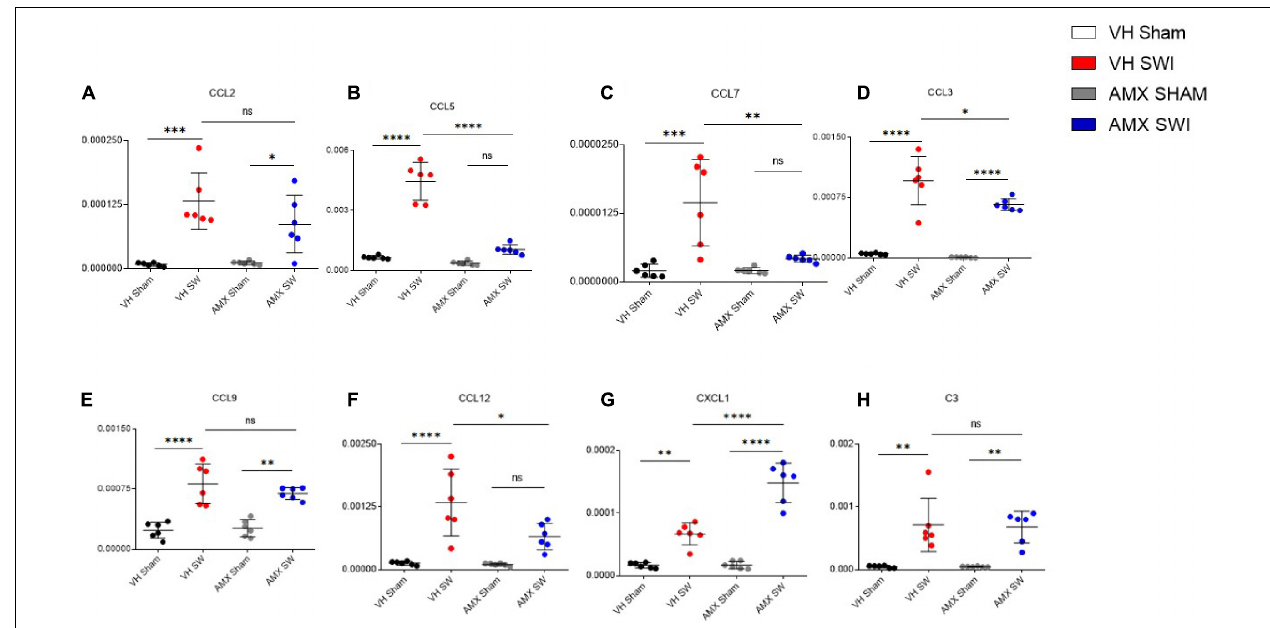
FIGURE 7 | Tbk1 blockade modifies the chemokine profile after Stab Wound Injury (SWI) injury. qPCR from whole-biopsy homogenates were obtained from the injury site (or the corresponding anatomical location in sham mice) from animals treated with either vehicle or AMX at 7 dpi. AMX strongly downregulated the expression of CCL-5 (B) , CCL-7 (C) , CCL-3 (D) , CCL-3 (E) , CCL-12 (F) but not of CCL-2 (A) , and strongly upregulated the expression of CXCL1 (G) . Expression of the complement factor C3 was unchanged (H) . ( n = 3 animals/group with 4 sections/animal. Average ± SD, plus individual data points indicated; two-way ANOVA with Tukey post hoc; ns: not significant, ∗ p < 0.05, ∗∗ p < 0.01, ∗∗∗ p < 0.001, ∗∗∗∗ p < 0.0001; full statistical report in Supplementary Table 9